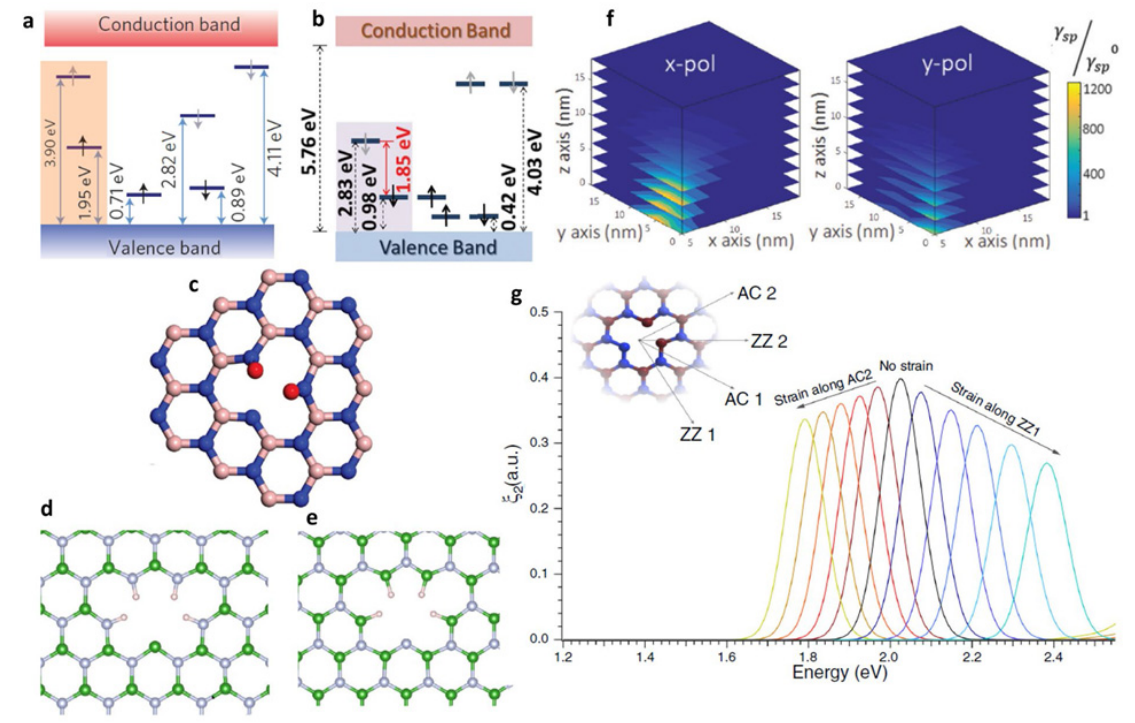
Figure 21. Simulated electronic structures of N B V N and VBO 2 defects, schematic representation of VBO 2 defect in hBN monolayer, boron and nitrogen dangling bonds, coupling of gold nanosphere to emitter in hBN multilayer flake, Strain directions and spectral tuning of hBN quantum emitter. ( a , b ) Electronic structures of N B V N and VBO 2 defect, in which 1.95 eV transition (transition from a ground state at 1.95 eV to an excited state located at 3.90 eV) and 1.85 eV transition (transition from a ground state at 0.98 eV to an excited state located at 2.83 eV) were highlighted, consistent with experimental studies and Only spin-preserving transitions are assumed and occupied and unoccupied states are represented by black and grey arrows. ( c – e ) Schematic representation of VBO 2 defect (Boron vacancy with two oxygen atoms (red colour)), Boron (green) and Nitrogen (grey) dangling bonds with hydrogen (white) passivated respectively. ( f ) Spontaneous emission enhancement ( γ sp / γ 0 sp ) due to defect coupling with gold nanospheres. ( g ) Effect of strain on NBVN defect structure [81].